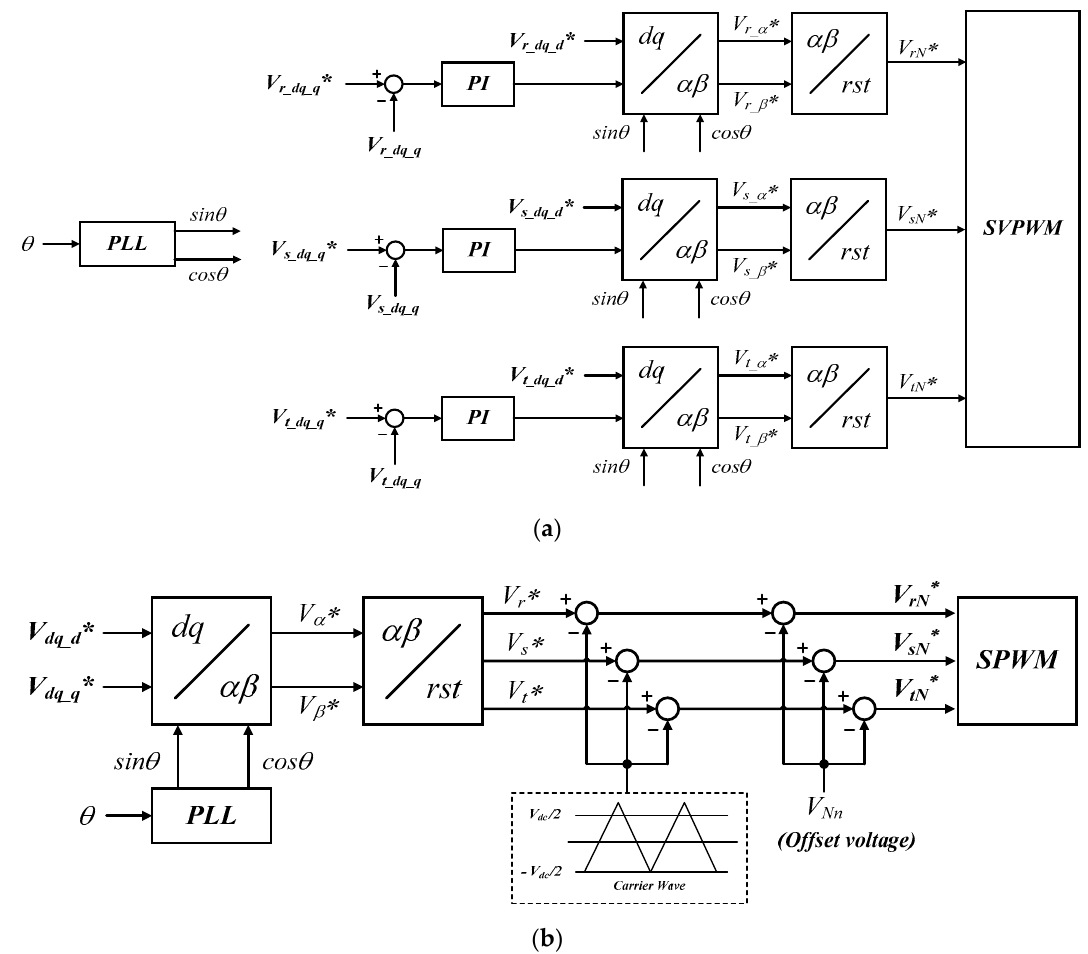
Figure 3. Control block diagram of an unbalanced 3-phase voltage compensation: ( a ) prior approach using independent control for each phase; ( b ) proposed approach using offset voltage of the neutral point of the load.